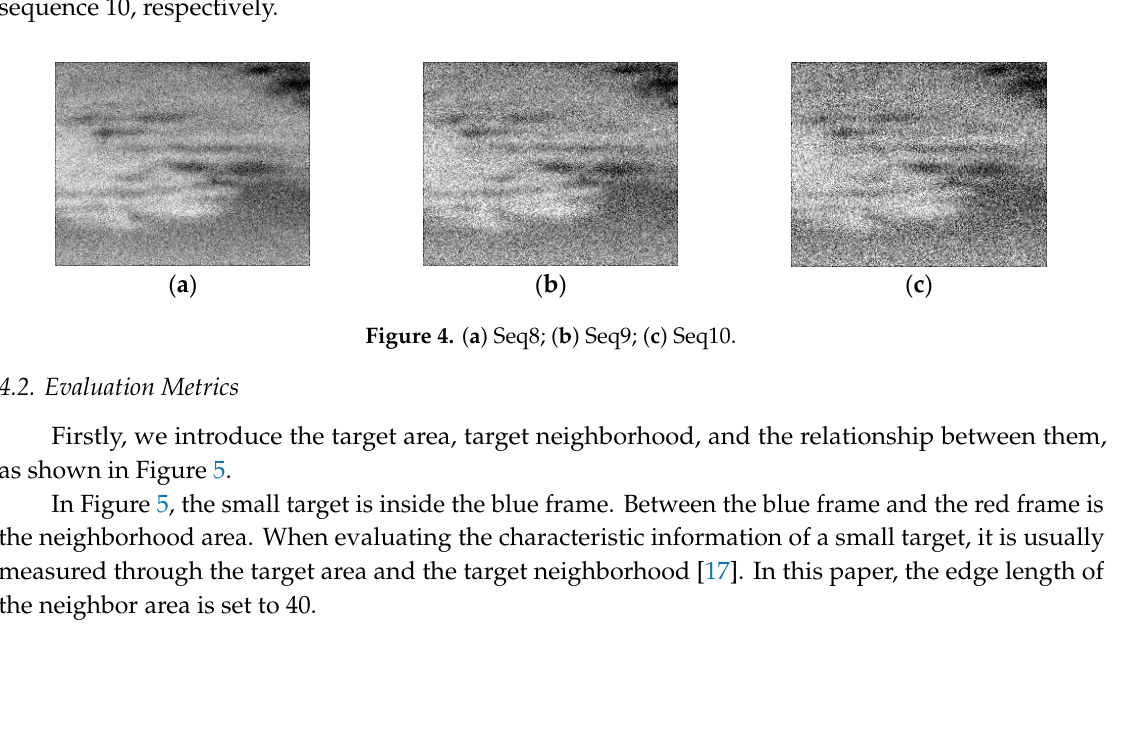
Figure 5. The neighborhood area of the target.